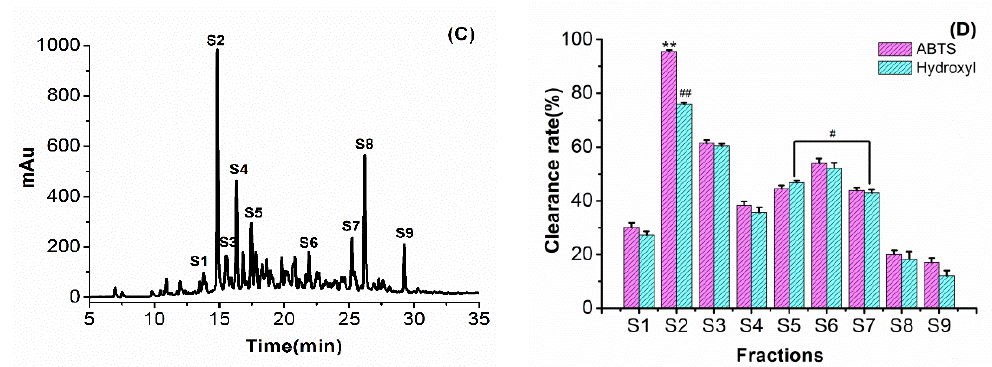
Figure 2. Separation and purification of antioxidant peptides and free radical-scavenging activity: ( A ) separation of peptide fractions (F4) on an anion exchange HiTrapTM Q HP column. ( B ) ABTS (2, 2’-Azino-bis) and hydroxyl radical-scavenging capability of di ff erent components (P1–P7) on a HiTrapTM Q HP column. ( C ) Separation of fraction P3 on C18 column. ( D ) ABTS and hydroxyl radical-scavenging capability of di ff erent fractions S1–S9. Results are shown as means ± standard deviation, n = 3; Duncan’s multiple range test was used for mean separation; ** p (##p) < 0.01 represents the di ff erence from other data in the group, * p (#p) < 0.05 represents the di ff erence between the two sets of data.